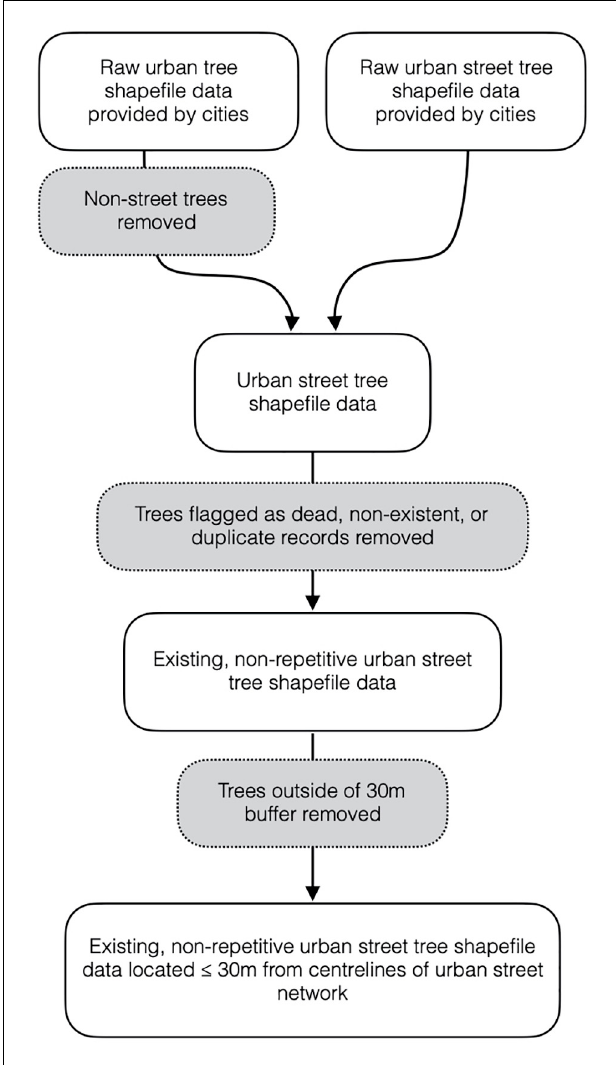
FIGURE 2 | Street tree data filtration